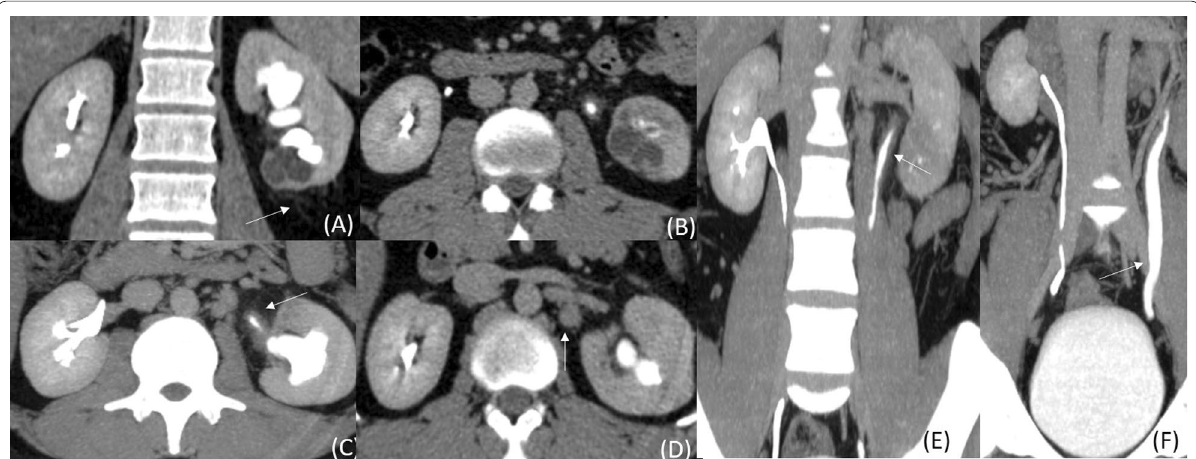
Fig. 16 Urinary tuberculosis involving left kidney, left pelvi-ureteric junction and left ureter. CT images of a 24-year-old male show lower pole caliectasis in left kidney ( A and B ) with surrounding fat stranding (white arrow in A ), there is thickening of pelvi-ureteric junction (white arrow in C ), an enlarged perinephric lymph node with loss of fatty hilum is seen (white arrow in D ) with thickening of left upper ureter (white arrow in E ) and dilatation of lower ureter (white arrow in F )